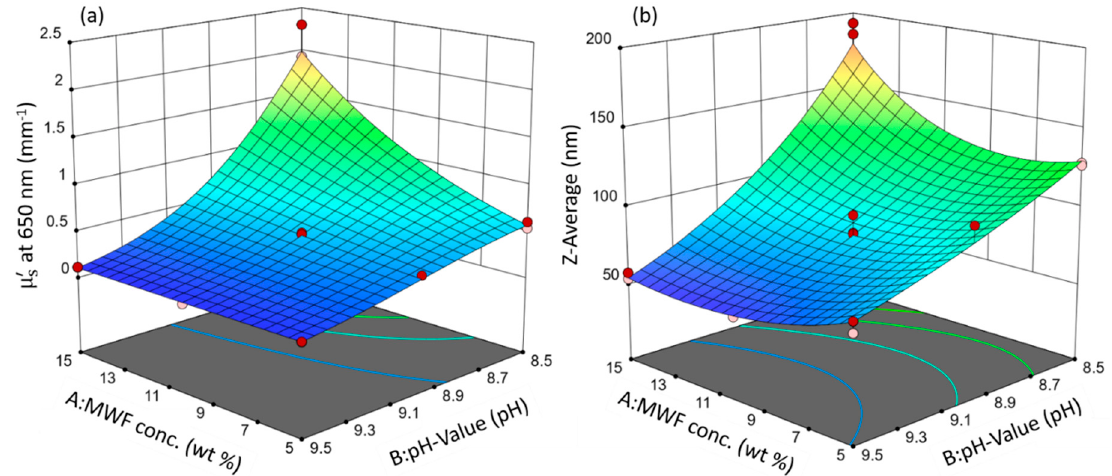
Figure 2. Response surface plots of the models: ( a ) µ’ s and ( b ) Z-average. Circles indicate design points. Response values increase from blue to red surface color.